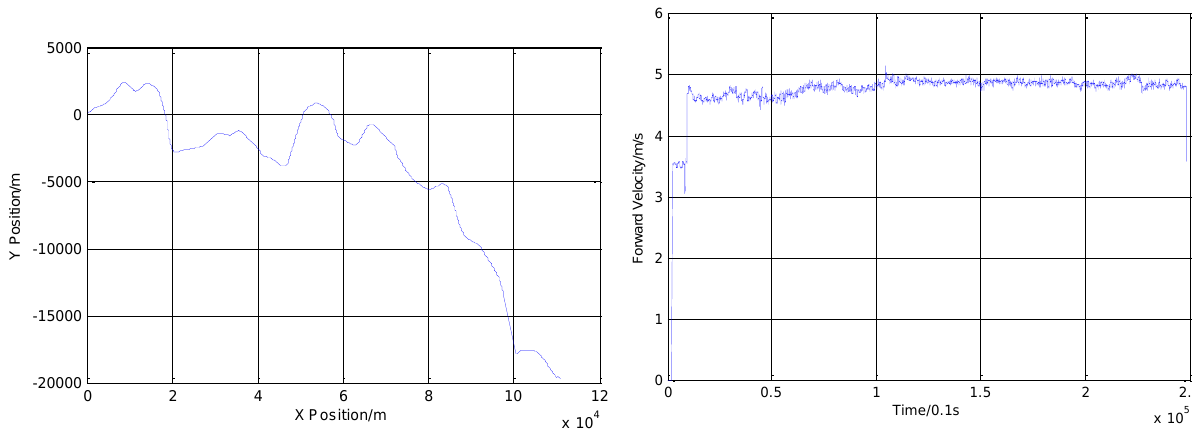
Figure 5. The trajectory and forward velocity of the vessel in a long distance river trial.